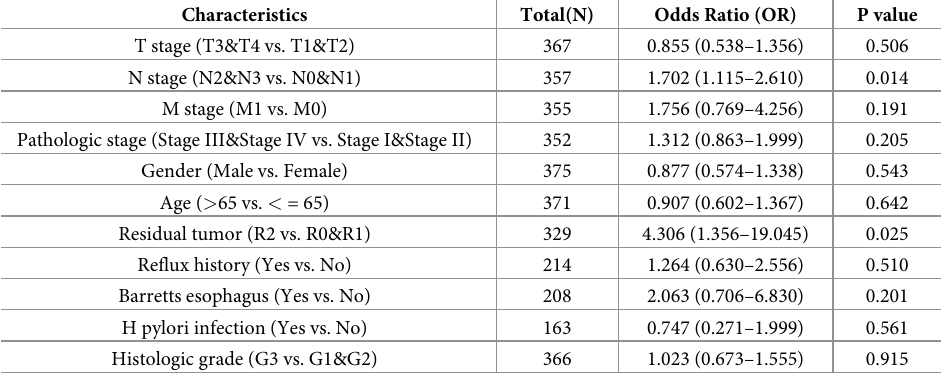
Table 2. The correlation between the expression of AKR1C2 and clinical characteristic parameters in GC patients from TCGA.